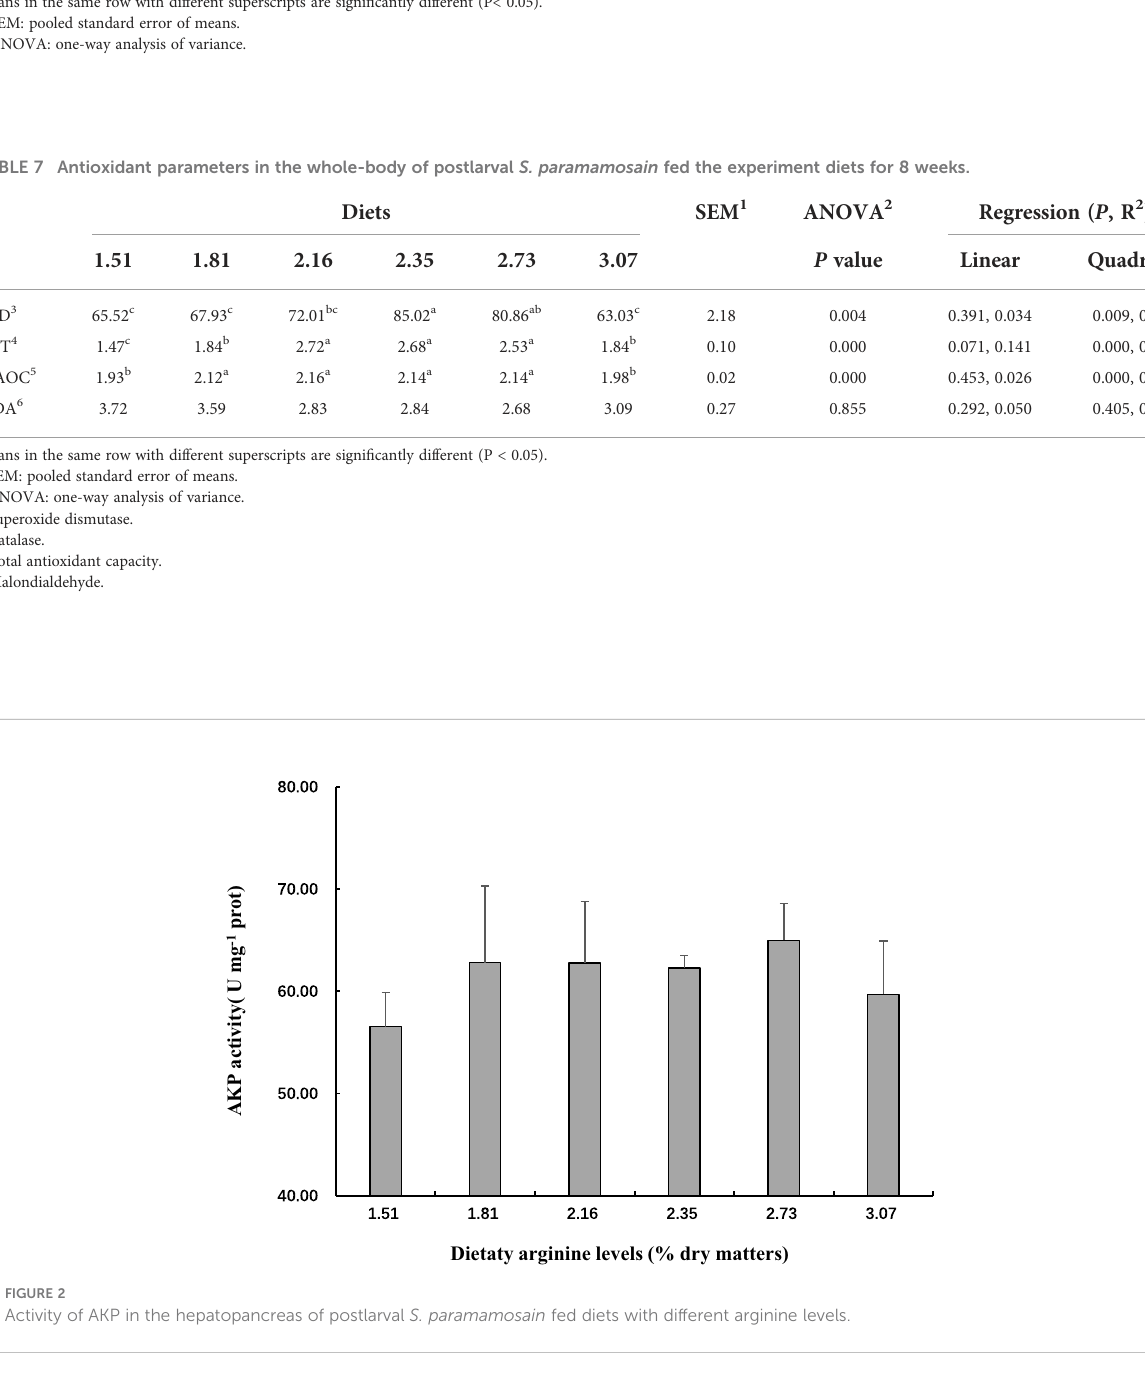
Means in the same row with different superscripts are signi fi cantly different (P< 0.05). 1 SEM: pooled standard error of means.